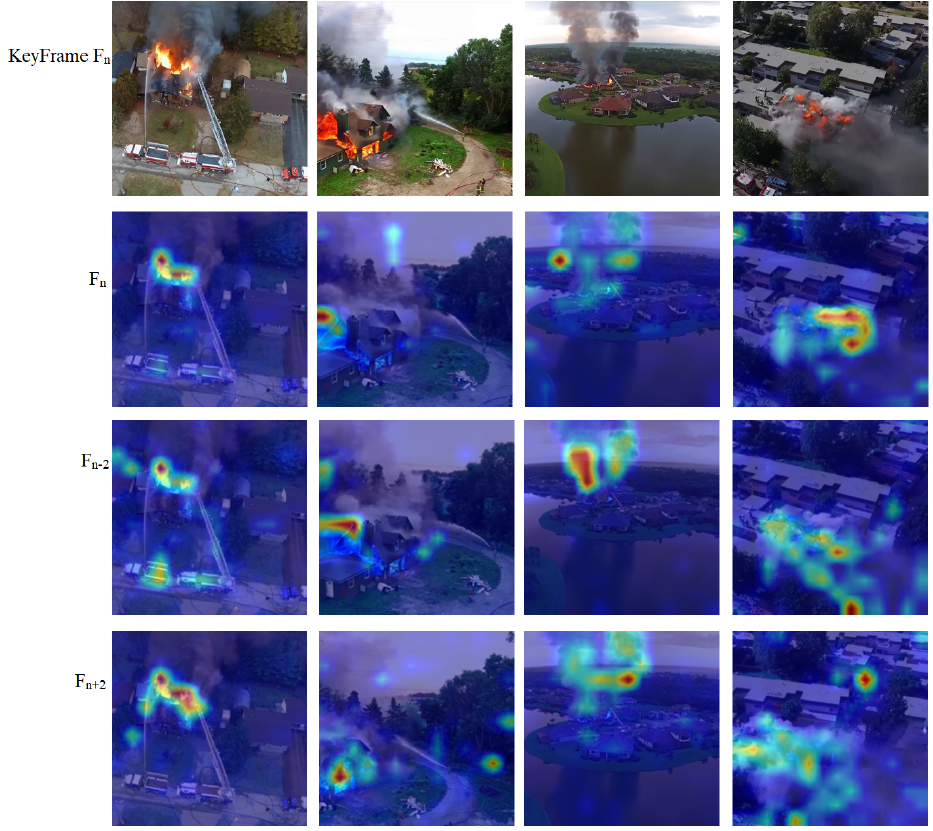
Figure 8. Attention map visualization of our model for fire pixels in keyframe F n , where we discov- ered the correlation with the other two reference frames [ F n − 2 , F n + 2 ] in the temporal window ( n ). Columns 1–4 are shown as